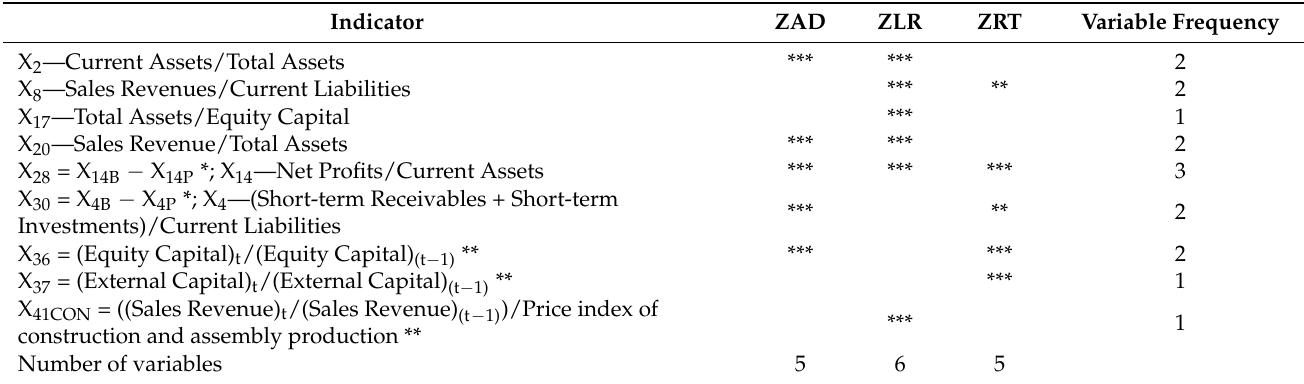
Table 5. Summary of ascending variables in constructed models.